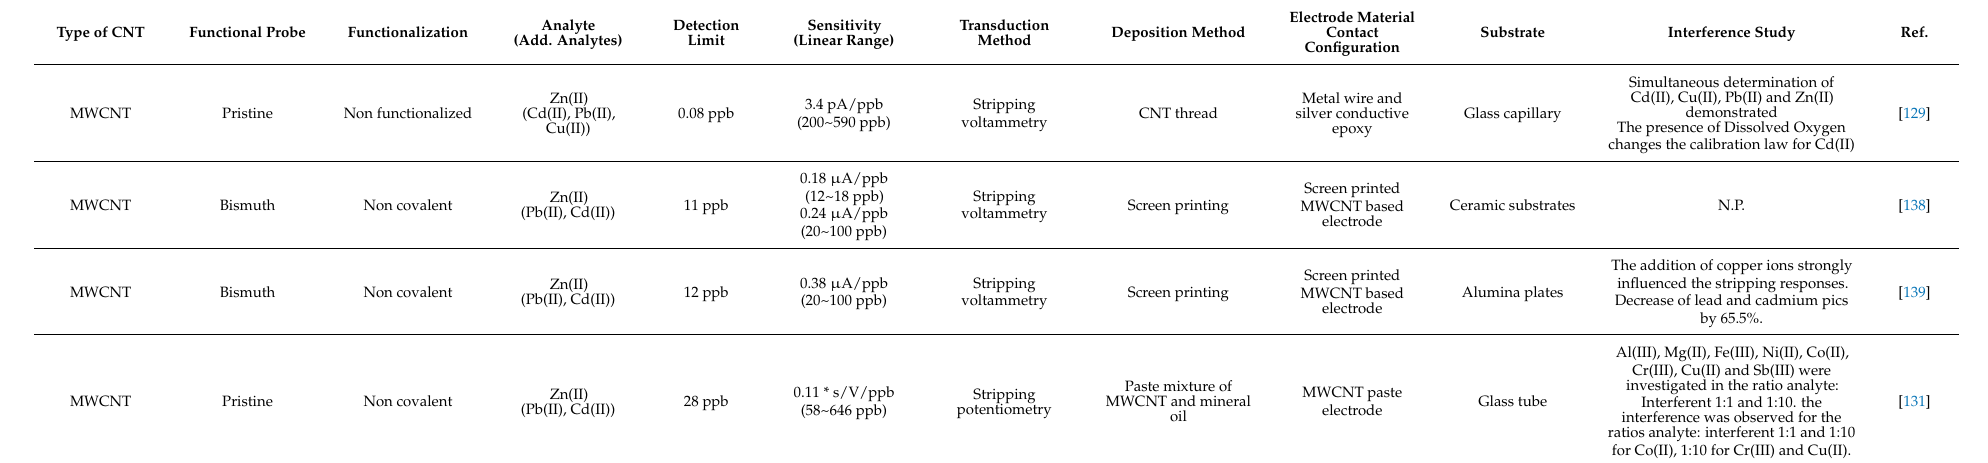
Table 5. CNT-based sensors for detecting Zn(II) ions in water, sorted by detection